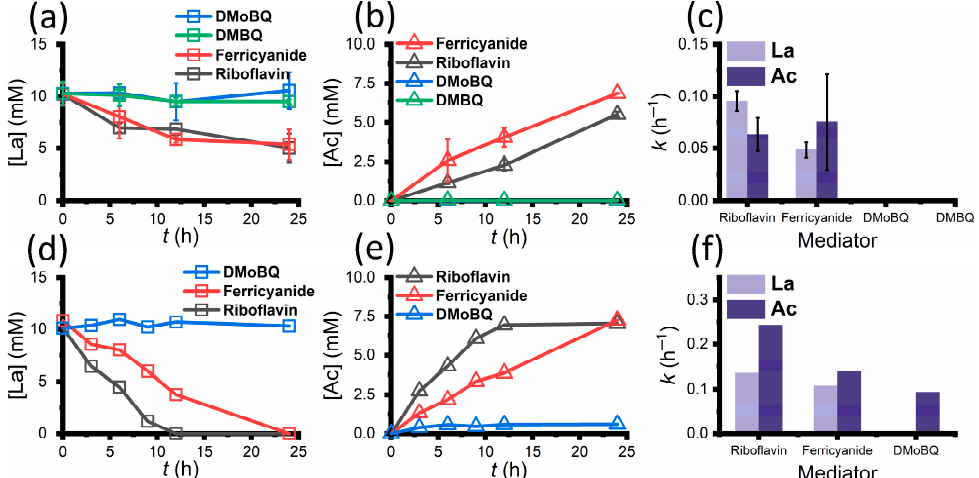
Figure 8. Organic-acid profiles and k -value estimations obtained with the controlled initial condition (10 mM lactate and OD 600 = 0.4–0.5) coupling different experimental conditions, including different concentrations of mediator addition (i.e., 5 μ M riboflavin, 2.5 mM ferrycyanide, 0.2 mM DMoBQ, and 0.2 mM DMBQ) with 1.0 mg mL − 1 ( a – c ) and 7.0 mg mL − 1 ( d – f ) of initial GO concentrations. ( a , d ) lactate profiles; ( b , e ) acetate profiles; ( c , f ) estimated k values; DMoBQ, 2,6-Dimethoxy-1,4-benzoquinone; DMBQ, 2,6-Dimethyl-1,4-benzoquinone; La, lactate; Ac, acetate. Furthermore, the aggregation of the reducing GO in the Hungate tubes standing still was observed every 6 h (Figure 9). With 5 µ M riboflavin and 2.5 mM ferricyanide externally